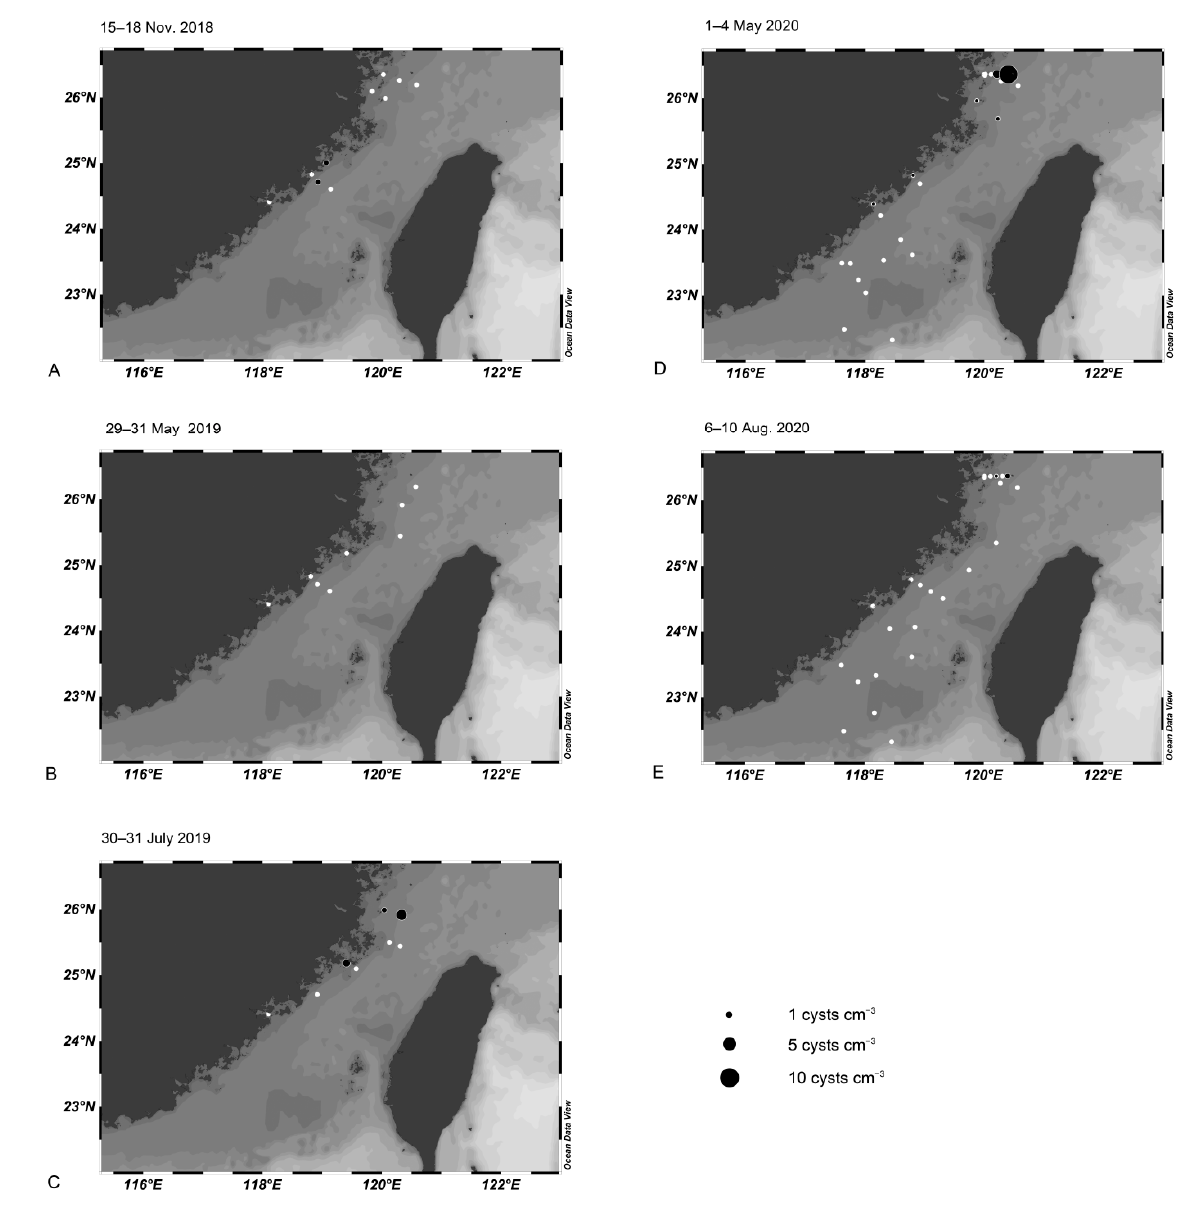
Figure 3. Cyst abundance (cysts cm − 3 ) of Alexandrium pacificum in sediment samples from the Taiwan Strait in November 2018 ( A ), May 2019 ( B ), July 2019 ( C ), May 2020 ( D ), and August 2020 ( E ). White dots represent collection sites where no cysts were detected.